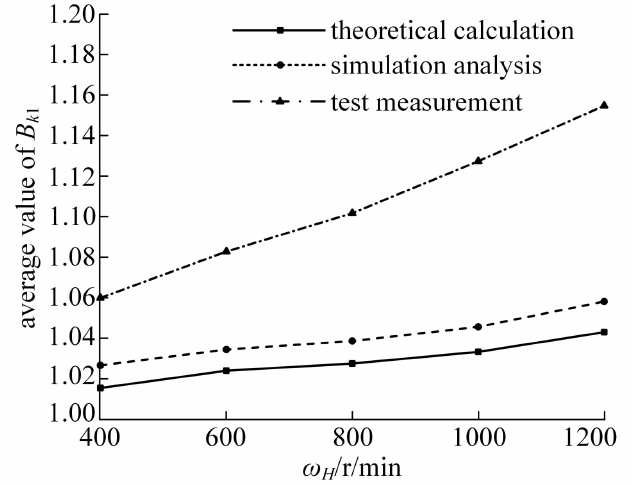
Figure 19. Variation curves of the average value of B K1 under different